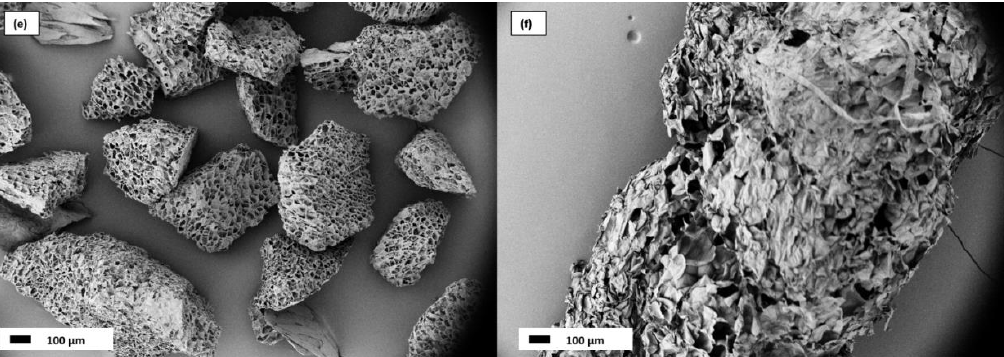
Figure 2. SEM micrographs at 100× magnification of: ( e ) coffee aerogels after water immersion test, ( f ) apple aerogels after water immersion test.